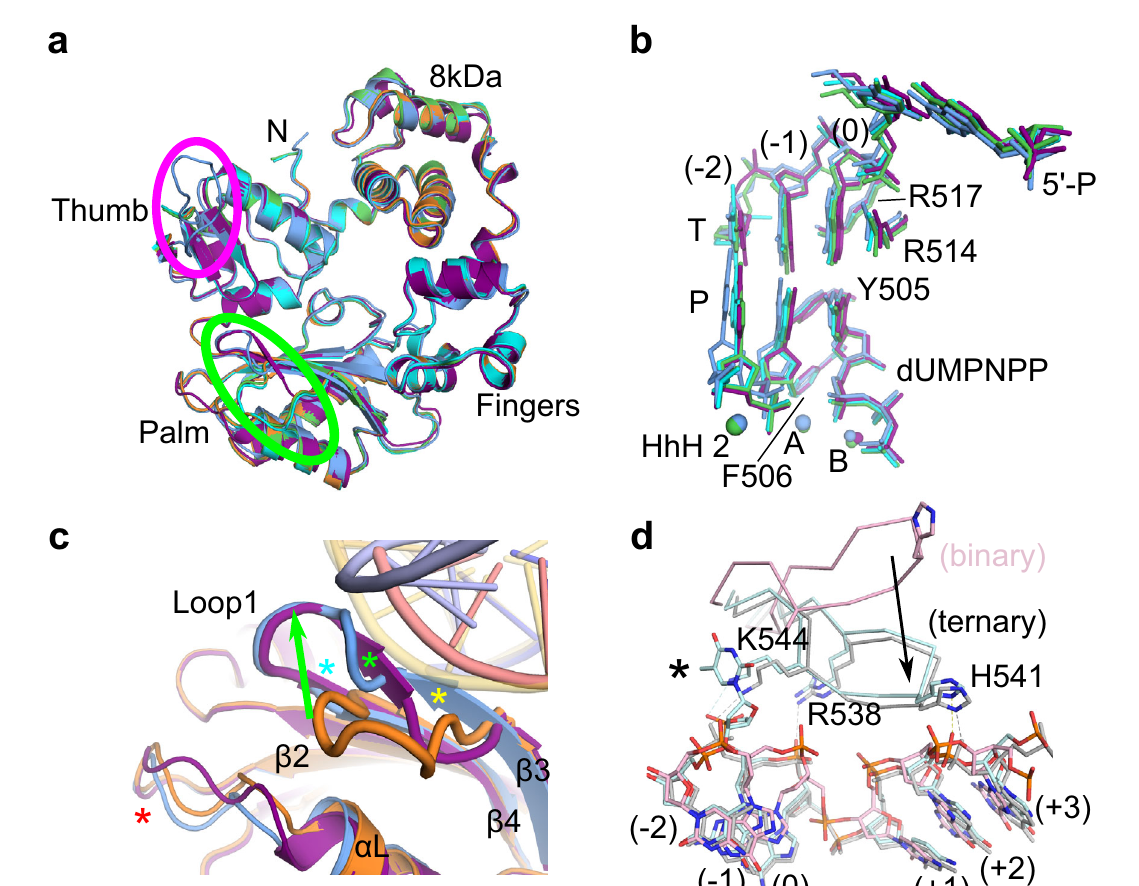
Fig. 9 Loop1 and ‘ thumb loop ’ adopt varying conformations to cradle different substrate con fi gurations. Superpositions of the global protein ( a ) and active site components ( b ) of the pre-catalytic SSB (orange), complementary DSB.A (blue) and DSB.B (purple), mispaired DSB.C (cyan), and blunt-ended DSB.D (green) synaptic complexes. c The upstream template region of the DNA substrate adopts variable trajectories in different complexes, which are, in turn, cradled by varying Loop1 conformations (SSB, protein in orange, DNA in transparent yellow; DSB.A, protein in blue, DNA in pink; DSB.B, protein in purple, DNA in light blue). These conformations alter the length and con fi guration of β -strands 3 (yellow asterisk) and 4 (cyan asterisk) and intervening secondary structure (green asterisk), which likely in fl uence the position of the loop between β -strand 2 and α -helix L (red asterisk). d Structural superpositions of the Pol λ ‘ thumb loop ’ observed in an ordered conformation in the canonical 1nt SSB binary (PDB ID code 1XSL 11 , pink) and 1nt SSB pre- catalytic ternary (PDB ID code 1XSN 11 , gray) complexes, relative to the 1nt strand-slippage intermediate (PDB ID code 2BCV 25 , light cyan, with extrahelical base marked with a black asterisk). Putative hydrogen bonding interactions are indicated by dashed lines in colors corresponding to the structure. Movement of the ‘ thumb loop ’ upon nucleotide binding is shown by a black